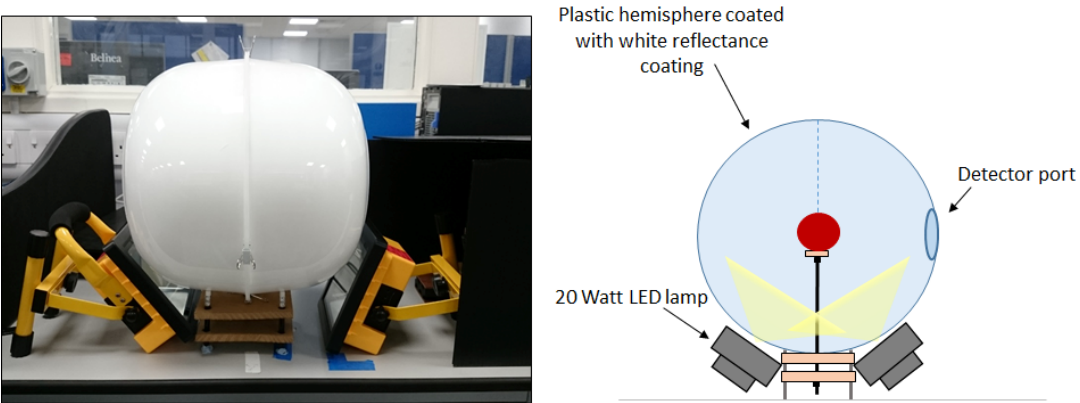
Figure 3. Low-cost integrating sphere set-up for image capture. Schematic not to Figure 3. Low ‐ cost integrating sphere set ‐ up for image capture. Schematic not to scale.